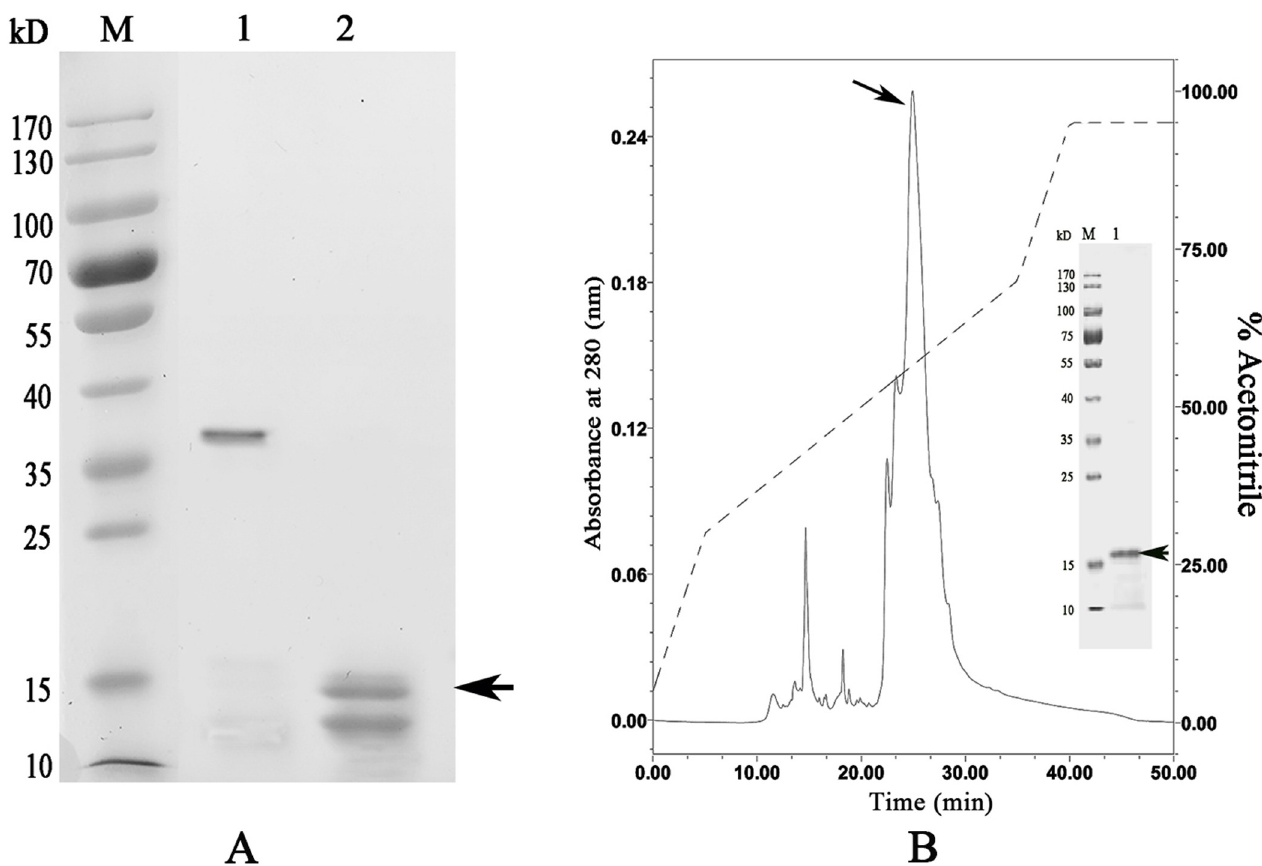
Fig 4. Enterokinase digestion (A) and HPLC purification of rWLP after digestion (B). Lane M, Protein Marker; lane 1, rWLP before enterokinase digestion; lane 2, rWLP after enterokinase digestion. The protein band with ~16 kDa (indicated by an arrow) corresponds to the rWLP.